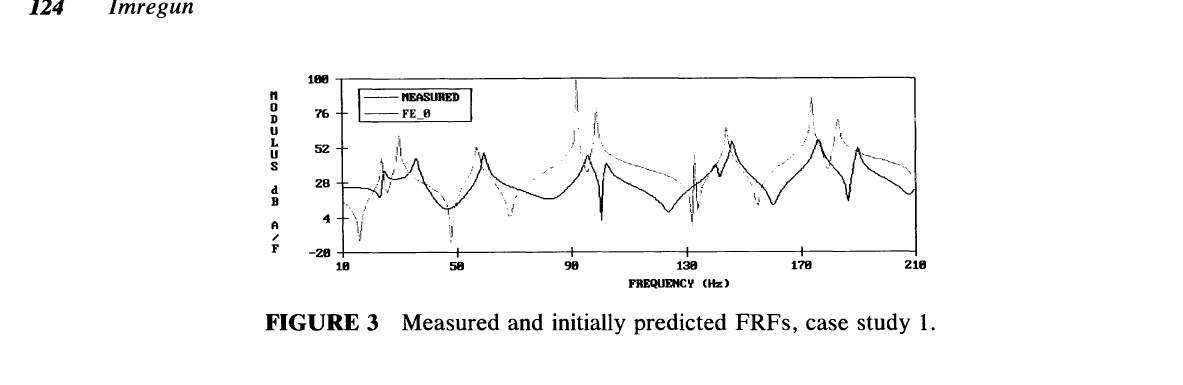
FIGURE 3 Measured and initially predicted FRFs, case study 1.